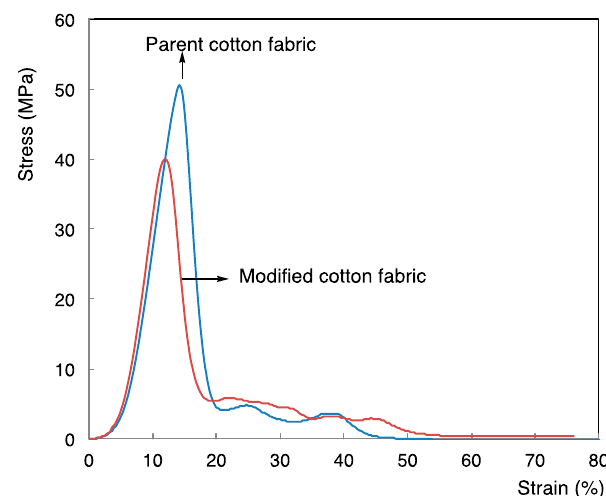
Figure 6. Stress–strain plots of the parent cotton swatch and the modified cotton swatch treated with R F -VMSiO 2 /TAZ nanocomposites (Run 1 in Table 2).